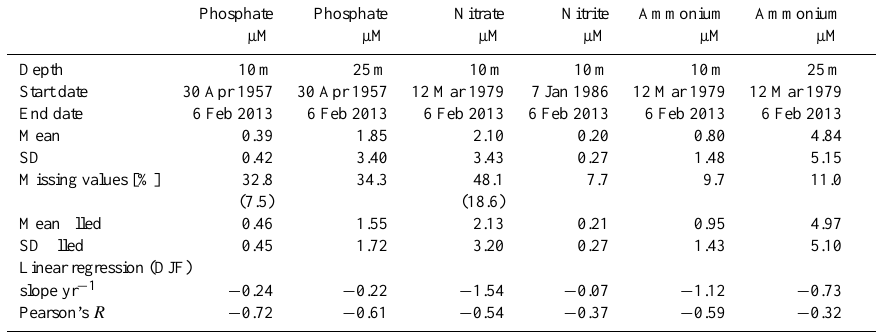
Table 5. Descriptive and test statistics for seasonal (MKT) and linear regression of winter (DJF mean) concentrations. Percentage of missing values in brackets refers to the part of the time series used for statistic analysis. SD: standard deviation; DJF: December-January-February. Phosphate